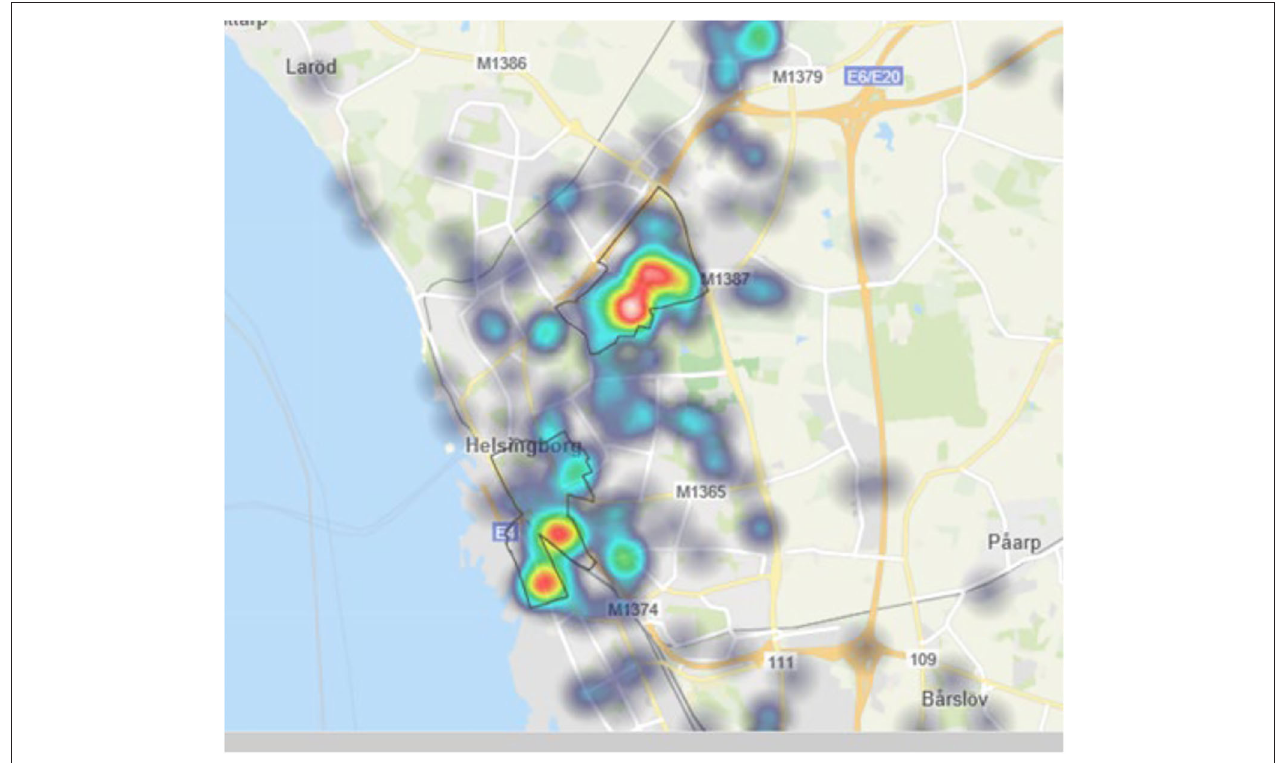
FIGURE 3 | Heat map for police district Helsingborg showing vehicle arson concentrations using the internal police IT